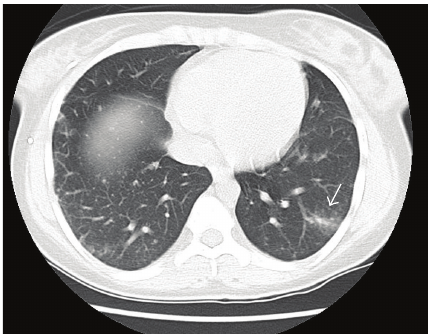
Figure 1: Compute tomography (CT) of chest showing wedge- shaped ground glass opacity in the left lower lobe, with surrounding centrilobular nodules (arrow). Additional 1-2mm centrilobular nodules noted in the right lower lobe.